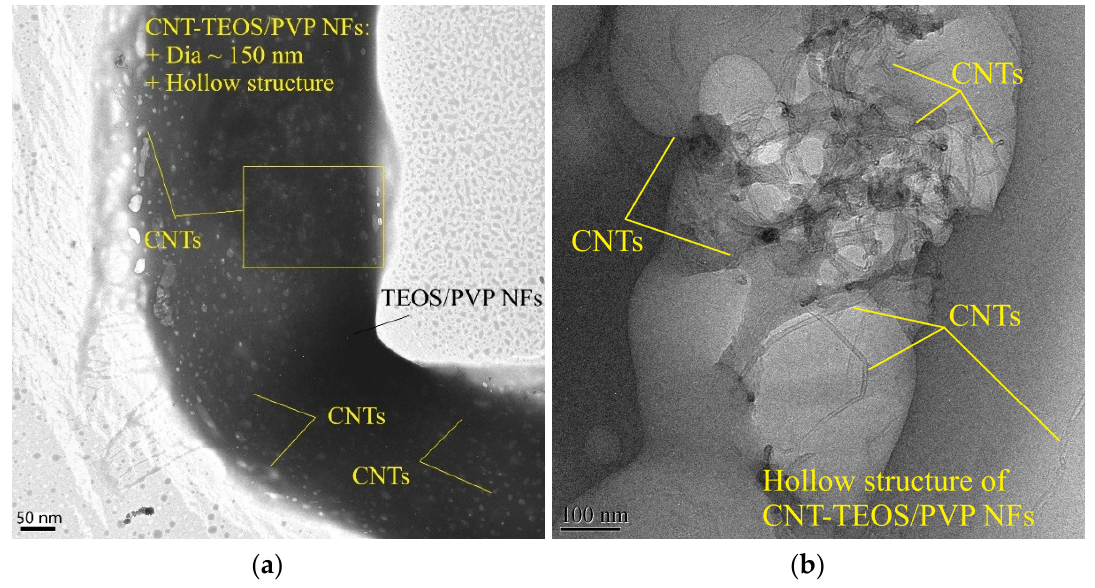
Figure 7. TEM image of CNT-TEOS/PVP NFs: ( a ) hollow structure of CNT-TEOS/PVP NFs and TEOS/PVP NFs; ( b ) presence of CNTs inside hybrid nanofibers.